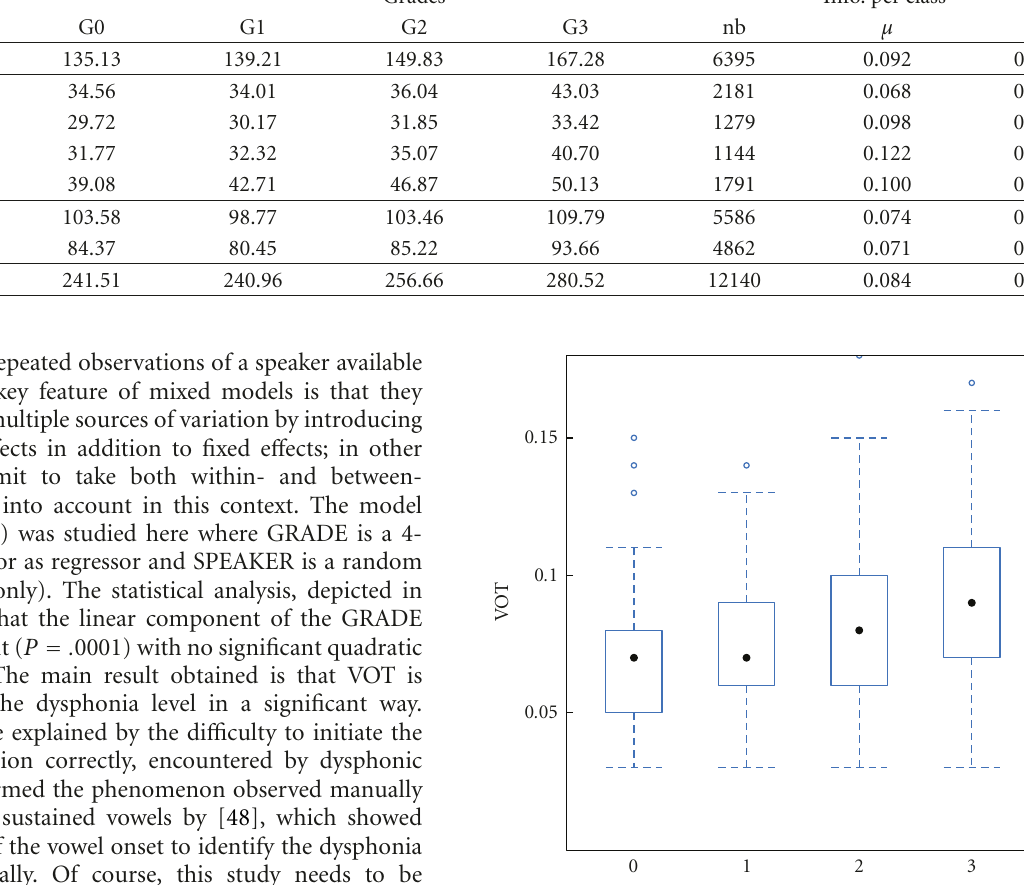
Figure 7: VOT (in seconds) according to the dysphonia severity grade (0: normal, 3:severe